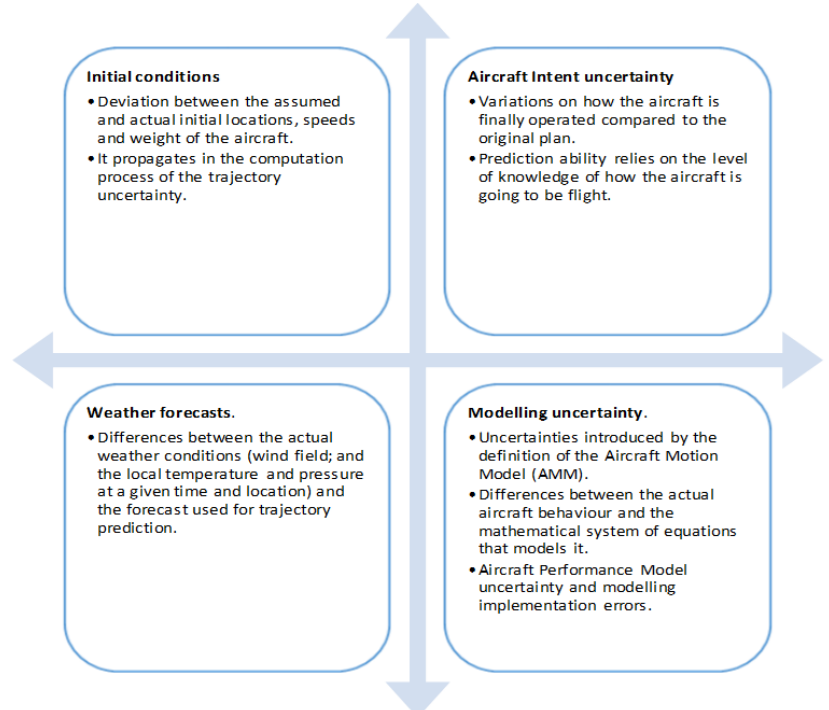
Figure 2. Influencing factors.